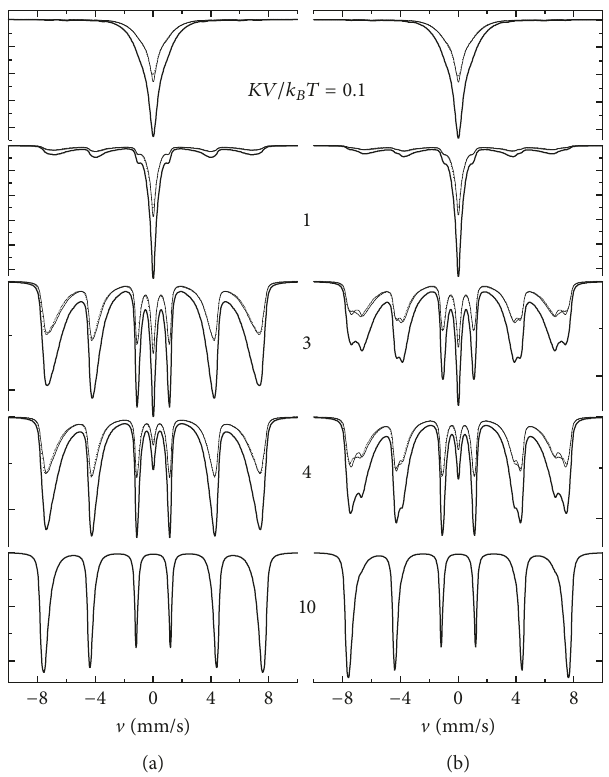
Figure 6: M¨ossbauer absorption spectra (solid lines) of 57 Fe nuclei in the ensemble of “uncompensated” antiferromagnetic particles with 𝛽 = 0.99 (a) and 𝛽 = 0.97 (b) calculated in the slow-relaxation regime for different values of the effective energy barrier 𝐾𝑉/𝑘 𝐵 𝑇 in the absence of the quadrupolar interaction ( 𝑞 = 0 ). Partial absorption spectra corresponding to the sublattice magnetizations M M 1 (thin solid lines) and 2 (dotted lines) are also